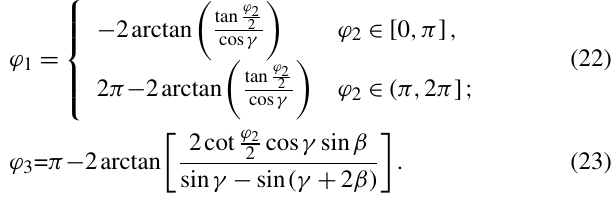
According to Eqs. (21)–(23), when ϕ 2 = π and ϕ 1 = ϕ 4 = ϕ 3 = ϕ 5 ≡ π , the pattern locates at the fully deployable con- figuration. While ϕ 2 = 0, ϕ 1 = ϕ 4 ≡ 0, and ϕ 3 = ϕ 5 ≡ 2 π , the pattern is always flat-foldable. To show the folding per- formance in detail, Fig. 5 shows the curves among upper- dihedral angles for γ = 3 π/ 4, 2 π/ 3, 5 π/ 12 when α = π/